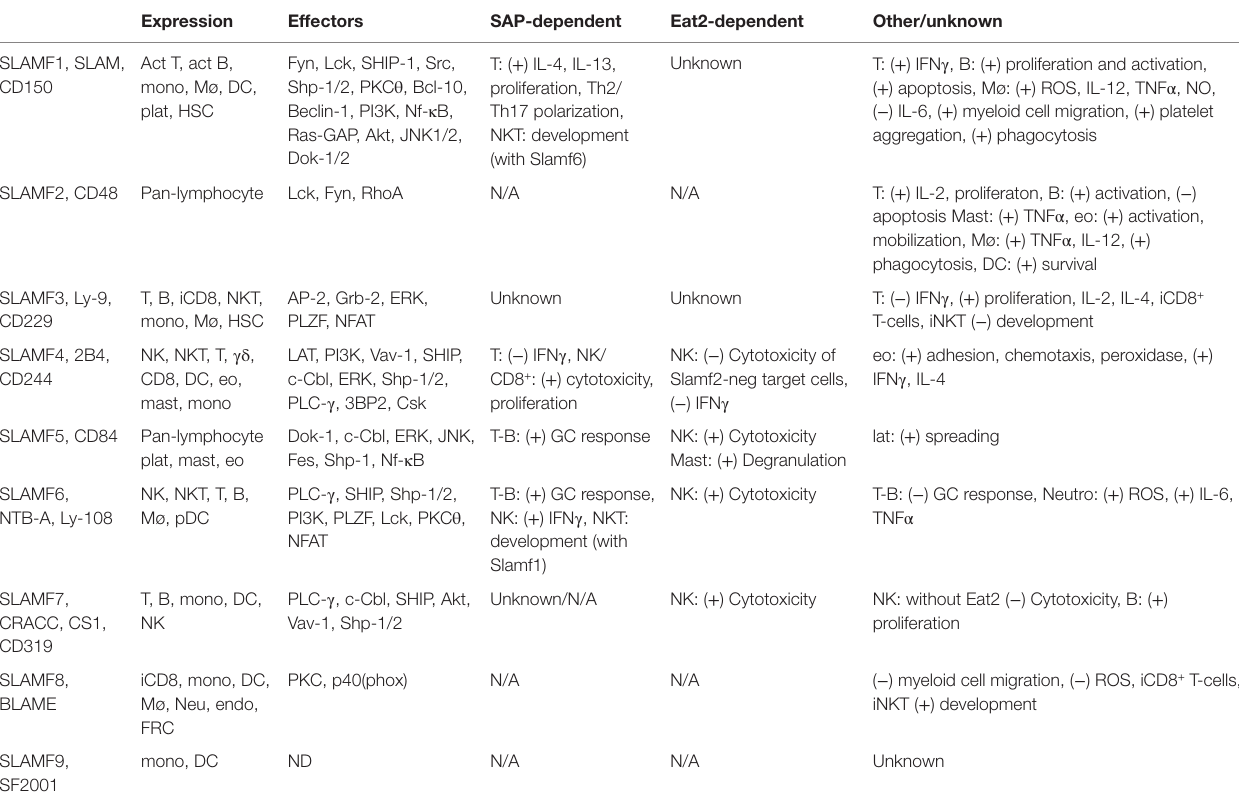
TABLe 1 | Slam receptor expression, associated effector molecules, and